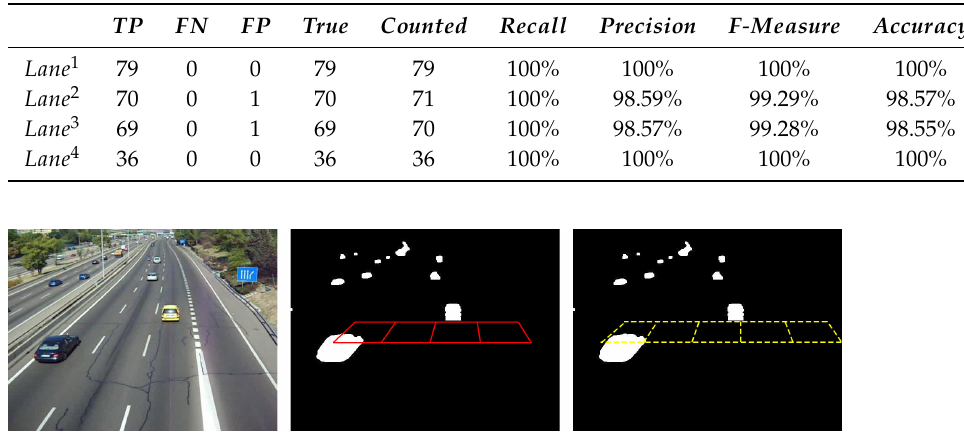
Table 9. Experimental results of Video I.